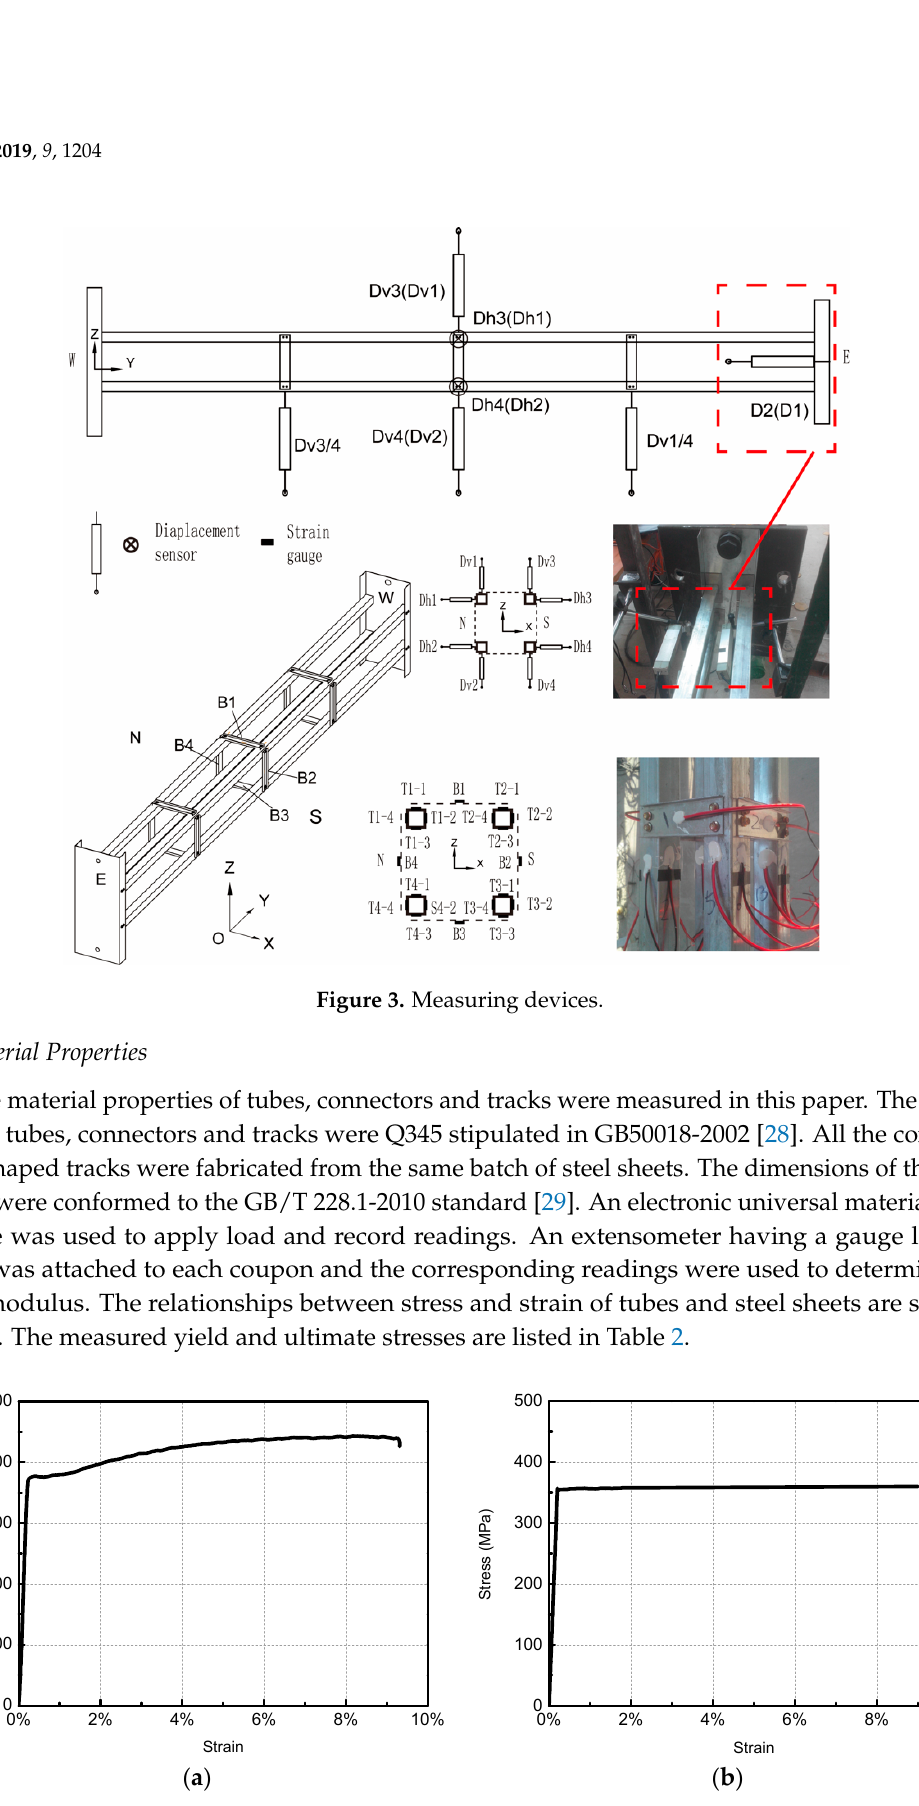
Figure 4. Stress–strain curves: ( a ) Tube; ( b ) Steel plate (connector and track).